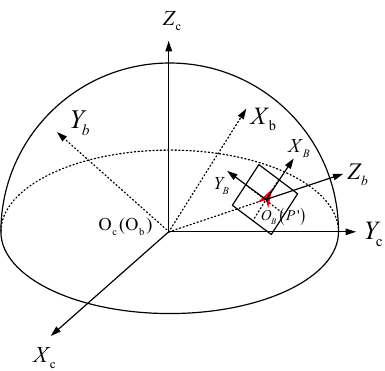
Figure 5. Position relationship between BRIEF template and spherical projection surface.